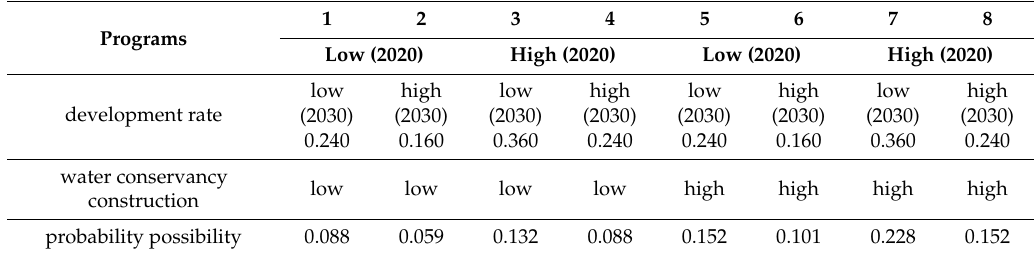
Table 7. Expert advice probability results table of di ff erent supply and demand programs in